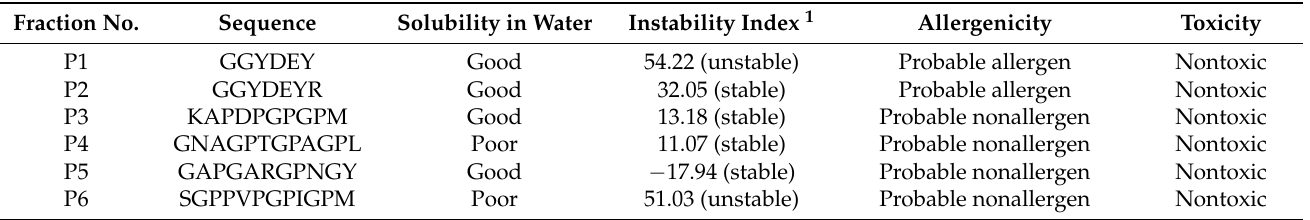
Table 5. Water solubility, stability, allergenicity and toxicity in silico prediction of tilapia skin identification